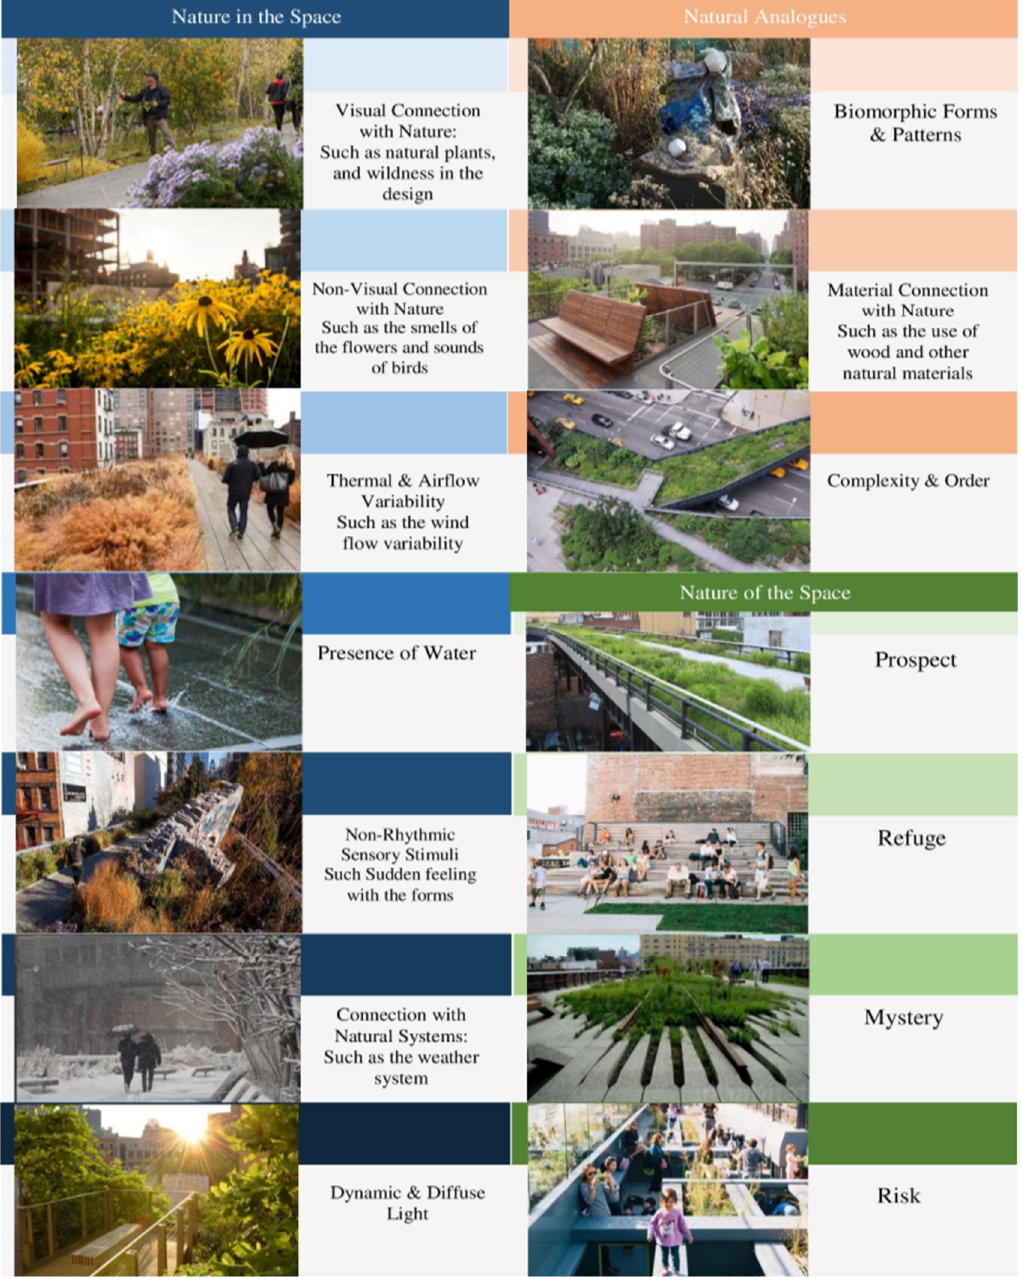
Figure 4. Biophilic patterns of the High Line. Diagram Source: Authors.